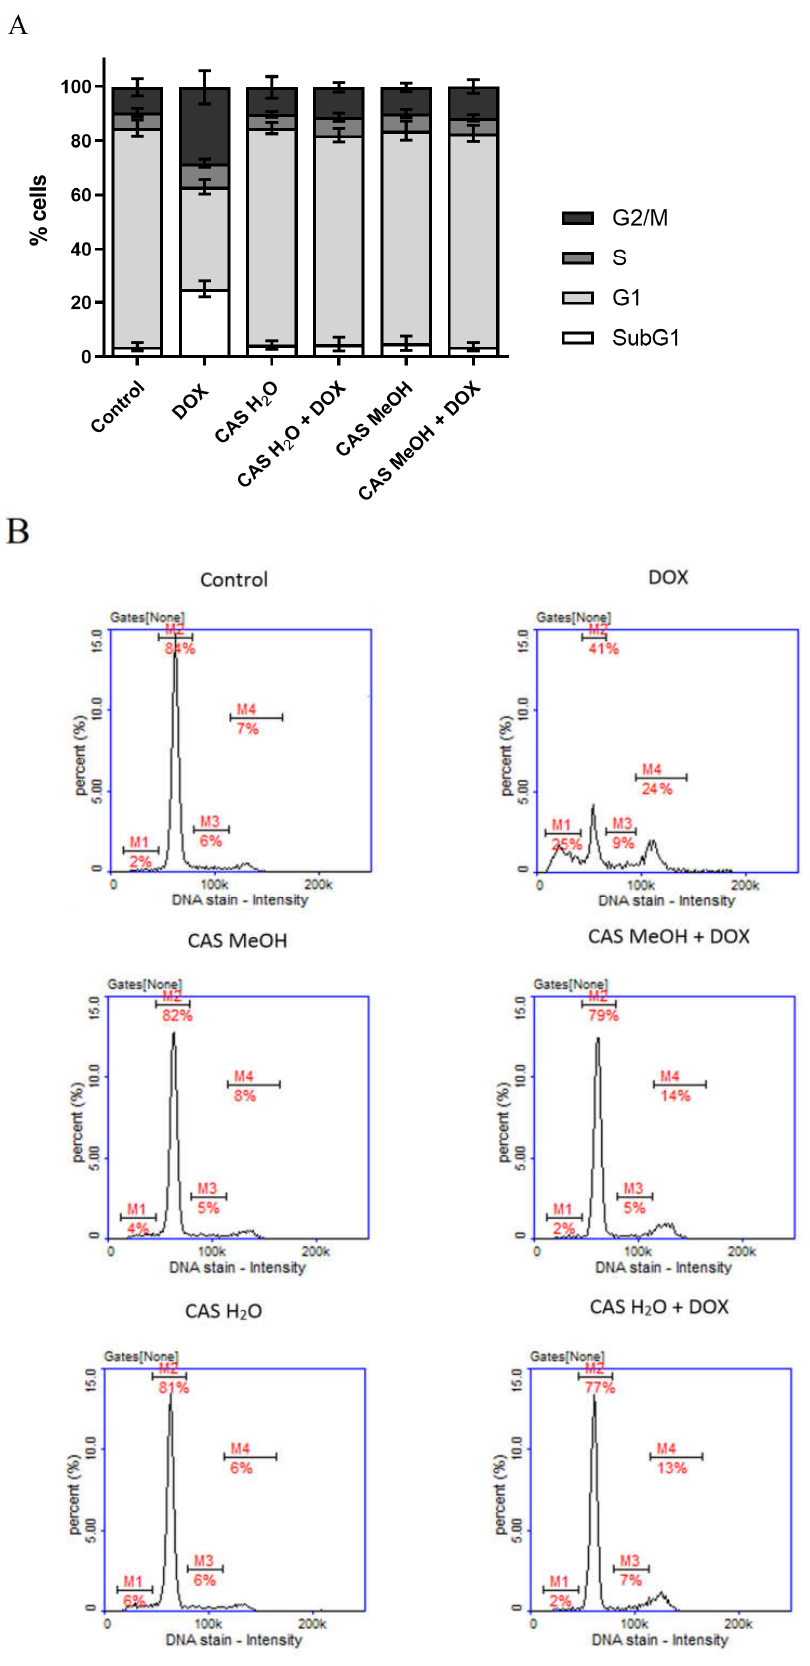
Figure 3. ( A ) Cell cycle analysis of H9c2 cells by image cytometry. Cells were treated for 48 h with 2 µM of DOX and 125 µg/mL of CAS H 2 O or 125 µg/mL of CAS MeOH, or a combination (DOX +